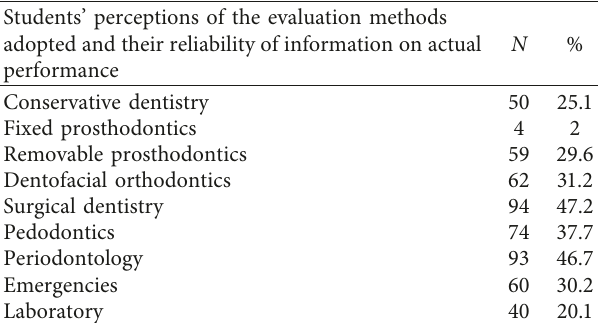
Table 4: Students’ perceptions of the evaluation methods adopted and their reliability of information on actual